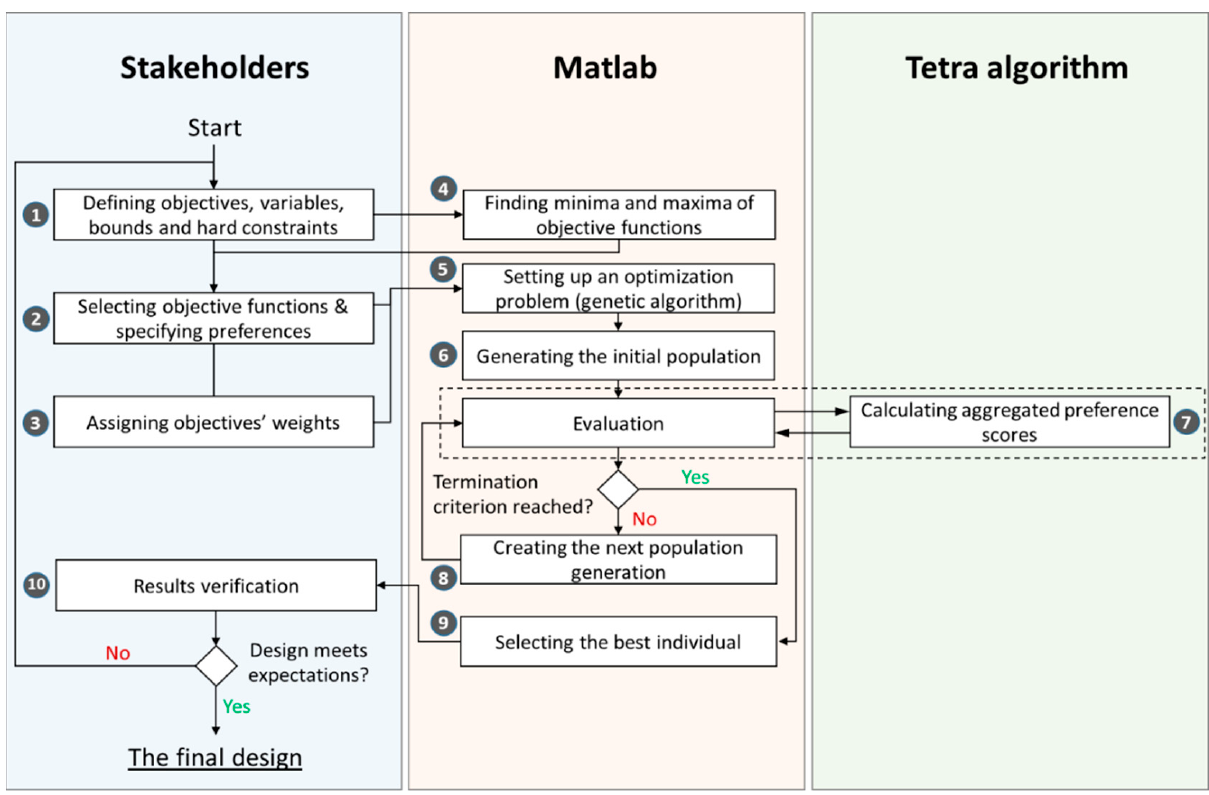
Figure 1. Methodology flowchart.